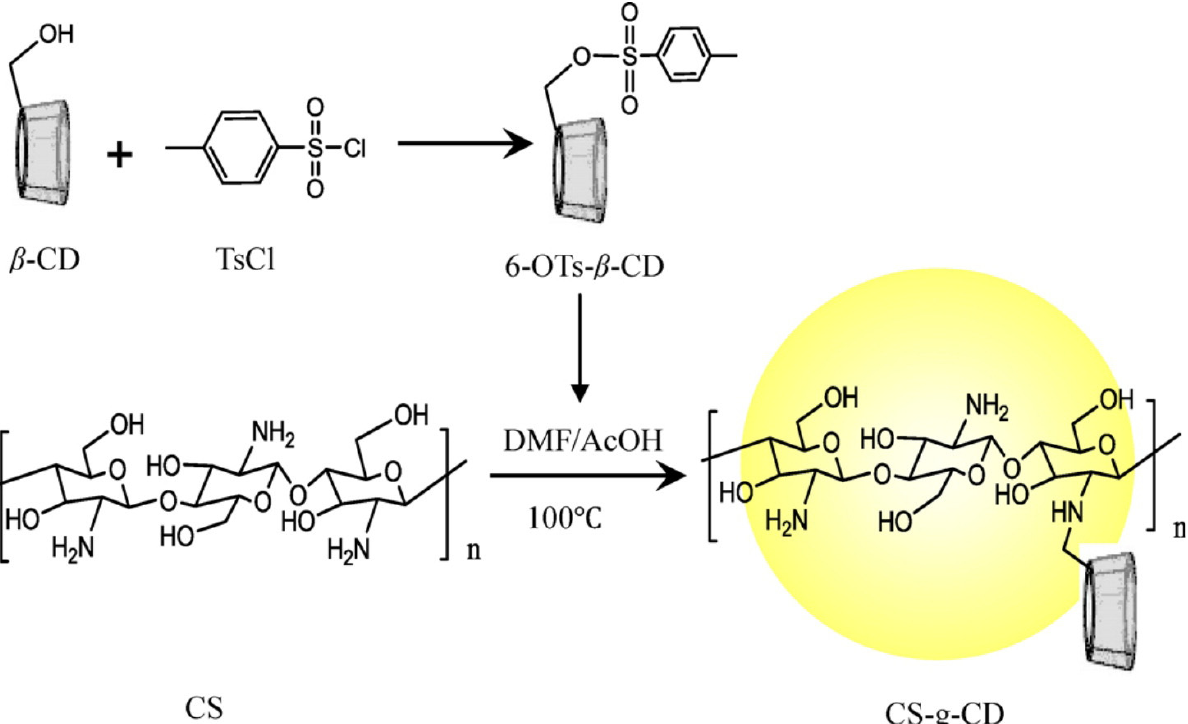
Figure 9. Reaction scheme for the synthesis of β -CD-CS derivative [236]. Reproduced with permission from Elsevier (Copyright©2013).